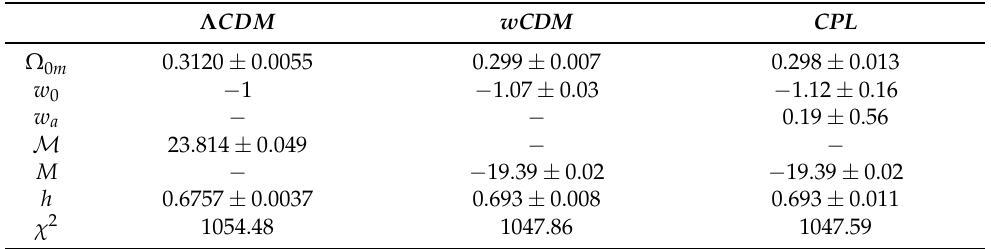
Table 4. Table containing the best-fit values for the Λ CDM , wCDM and CPL models using both the CMB and BAO measurements, data from Type Ia supernovae and the Riess